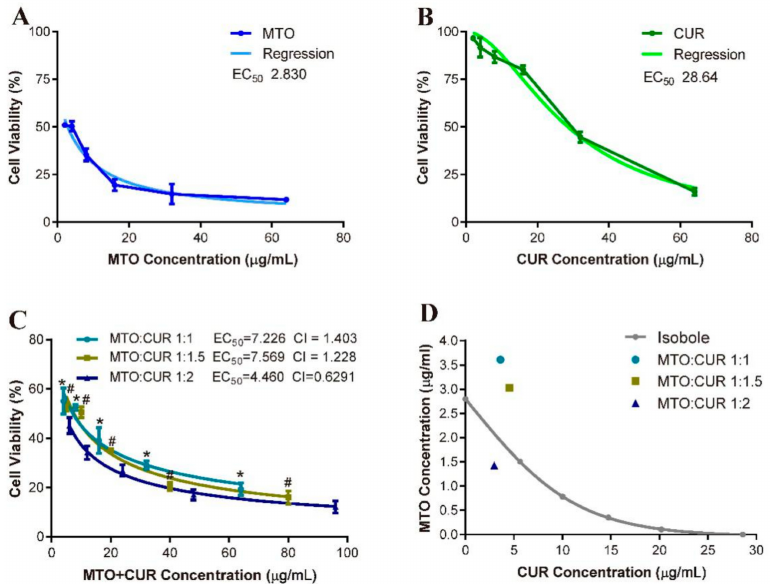
Figure 8. Dose–effect curves and regressions of: free MTO ( A ); and free CUR ( B ); the combination of MTO and CUR at the combination ratio of 1:1, 1:1.5 and 1:2 ( C ); and the isobole ( D ). Data represent means ± SD ( n = 6). Statistics: * indicates significant differences between the models of MTO:CUR at 1:1 and 1:2 ( p < 0.05); # indicates significant differences between the models of MTO:CUR at 1:1.5 and 1:2 ( p <